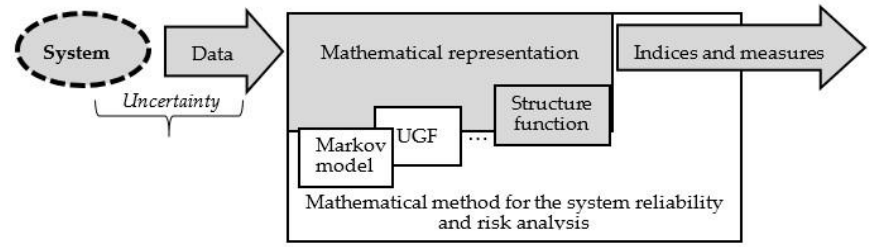
Figure 1. The structure of the system reliability and risk analysis.